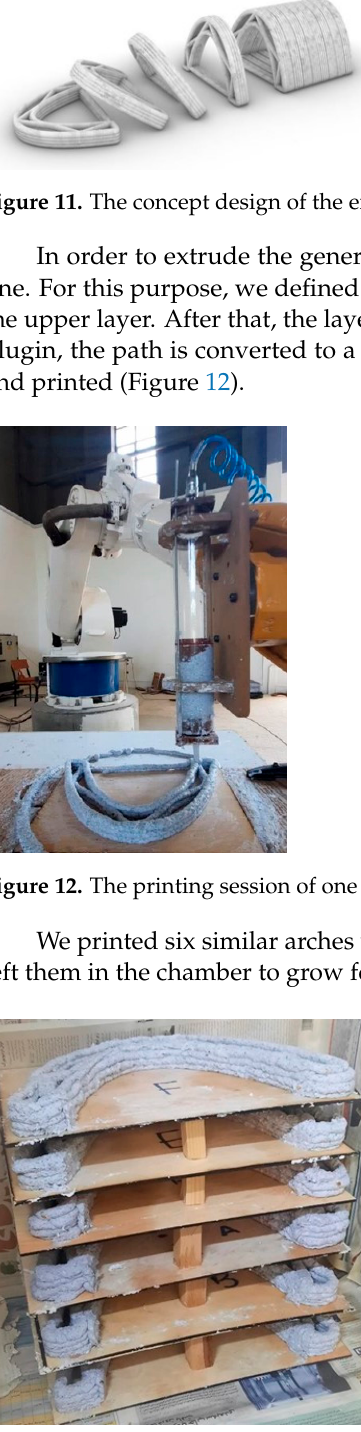
Figure 10. The extruded lattice brick (Image credit: Authors).